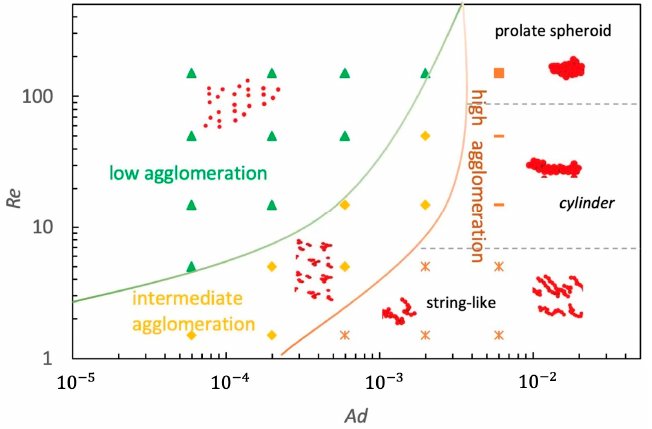
Figure 5. Agglomeration regime map. Phase diagram illustrating the observed cases as a function of the Reynolds and adhesion numbers at α = 2.4%. The simulation results of solid volume fraction at α = 1.2% and α = 2.4% were similar. For simplicity and to avoid repeated comparisons, here we only compared simulation results at α = 2.4% and α = 4.2% in order to investigate the effect of α .